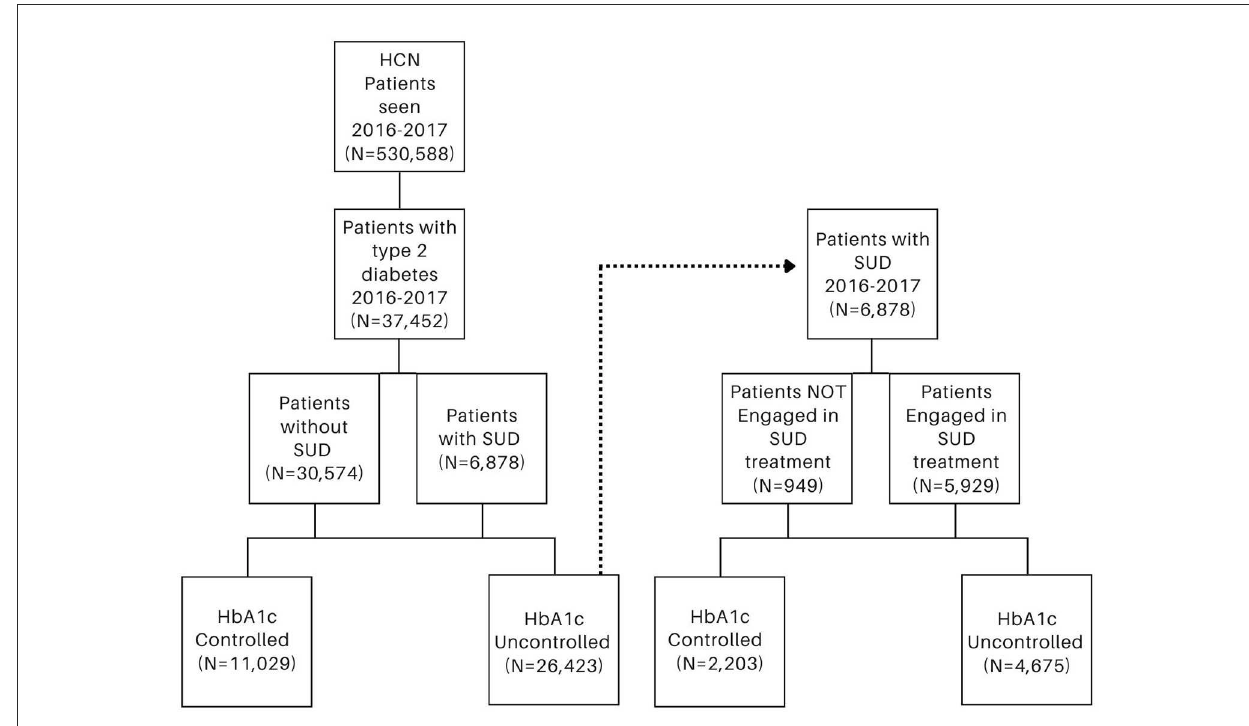
FIGURE1 Participant sub-groups among patients with type 2 diabetes (left) and among patients with substance use disorder (SUD) (right) .